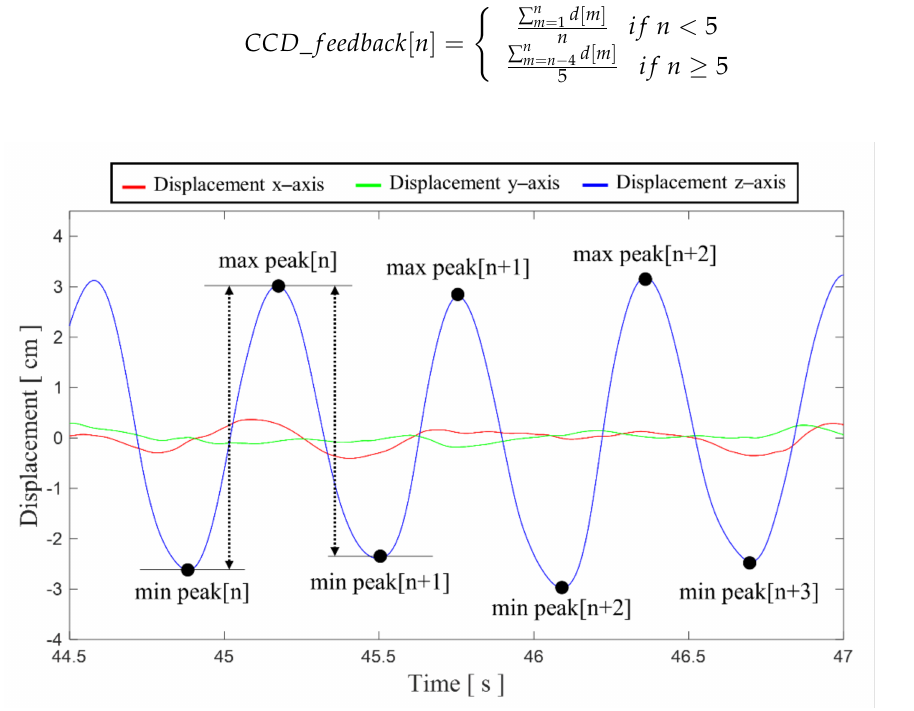
Figure 4. Example of min and max peaks on the displacement waveform for [ n ], [ n + 1], [ n + 2]th chest